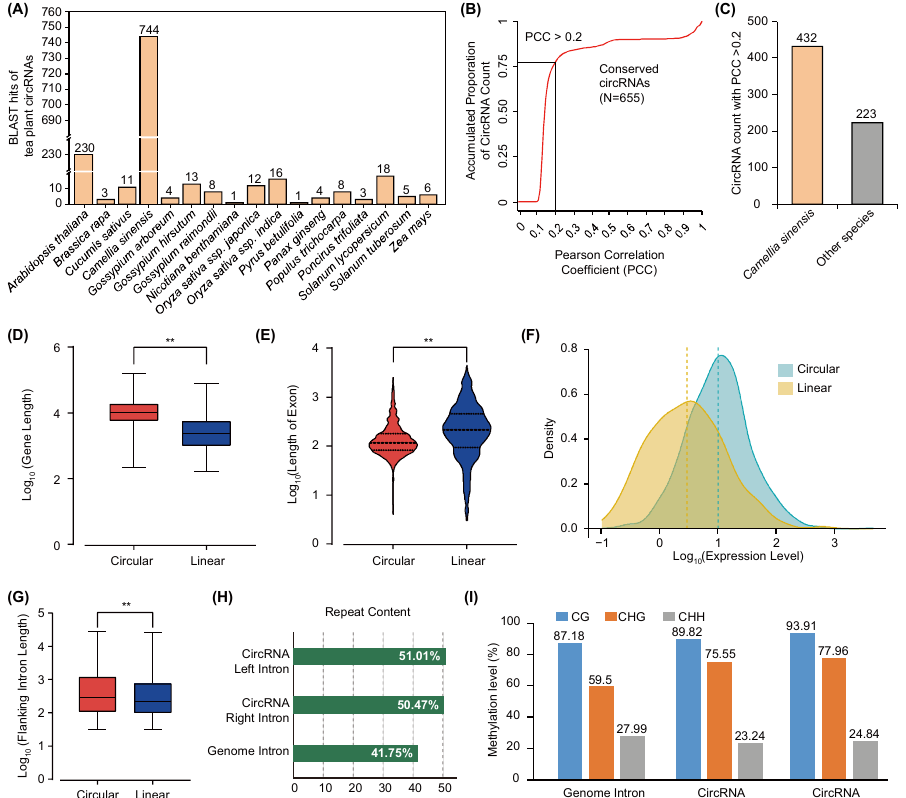
Figure 2. Conservation assessment of circRNAs in diverse plant species. ( A ) Similarity analysis of tea plant circRNAs with other plant species using junction sequences. ( B , C ) Similarity analysis of tea plant circRNAs with other plant species using K-mer -based method. ( D ) Comparison of gene lengths between genes with and without detectable circRNAs. ( E ) Exons length between genes with and without detectable circRNAs. ( F ) Expression levels (FPKM) between genes that can produce circRNAs with genes without detected circRNAs. Linear and circular represent randomly selected genes without detectable circRNAs and genes with detectable circRNAs in tea plant genome annotation, respectively. ( G ) Flanking-intron length between linear transcripts and circRNAs. Y -axis in the above subfigures is indicated by log 10 of gene length, exon length, and intron length (bp). ** indicates significant difference between groups ≤ 0.01. ( H ) Repeat sequence content of flanking intron regions of circRNAs and randomly selected genes. ( I ) Methylation patterns around flanking introns of circRNAs. Weighted methylation level was calculated here.